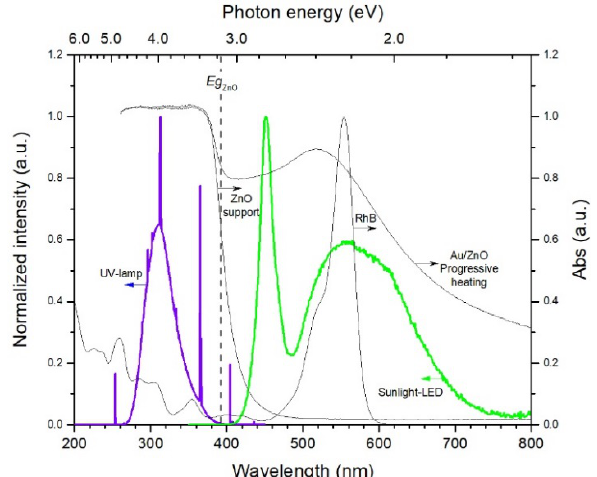
Figure 6. Emission spectra of the UV-lamp and sunlight-LED used as light sources in the photocatalytic experiments. Absorbance spectra of the ZnO support, a representative Au-NPs/ZnO sample, and RhB are shown for comparison.